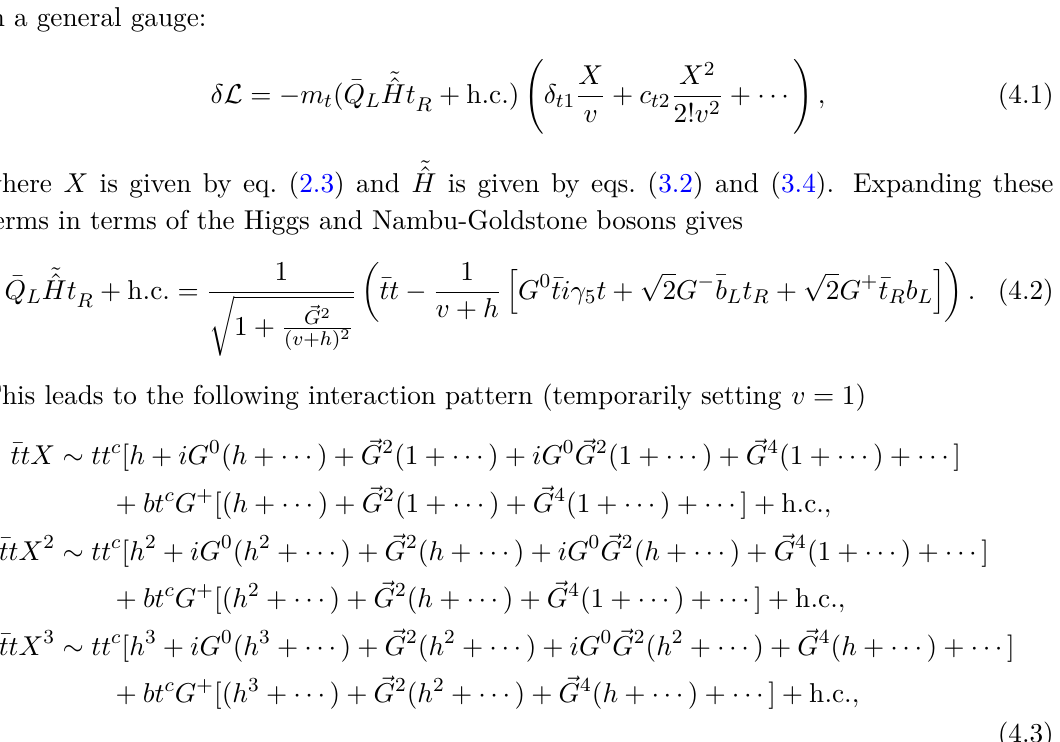
in unitary W − L L